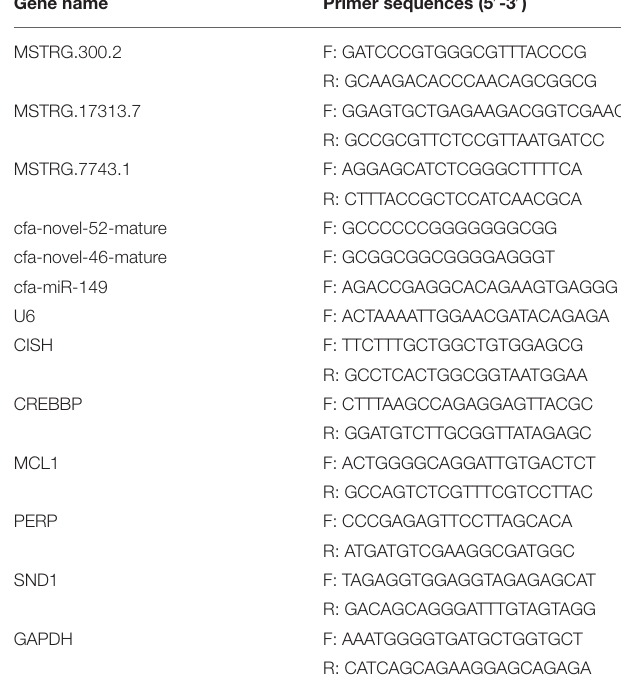
TABLE 2 | Primer sequences used for real-time PCR.